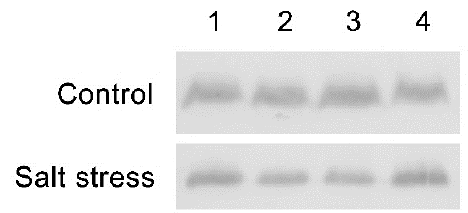
Figure 6. PsbD protein expression of the Arabidopsis wildtype (WT) (lane 1), at1g65230 mutant (lane 2), and revertant line; rev-1 (lane 3) and rev-2 (lane 4) determined after 10 days of culturing under control and salt-stress conditions. under control and salt-stress